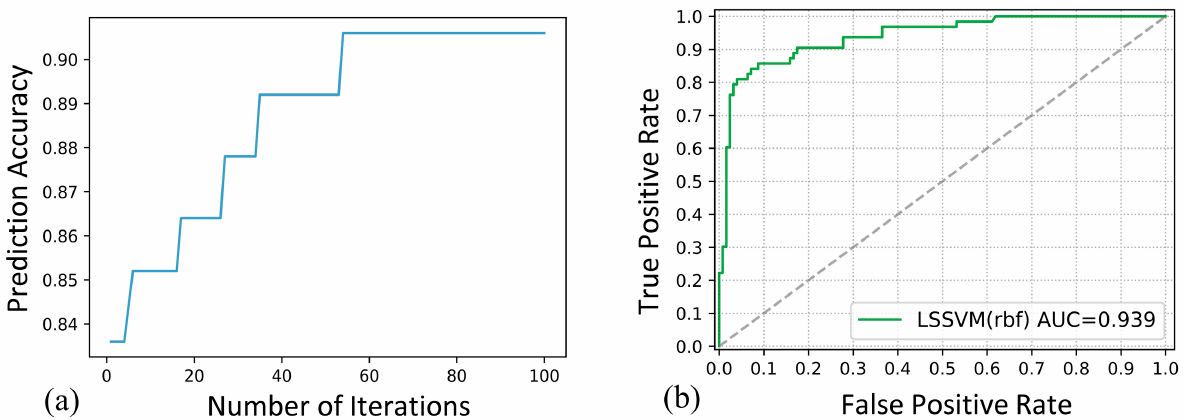
Figure 10. Prediction model performance: ( a ) Model accuracy after genetic optimization and ( b ) Forecast model ROC curve.